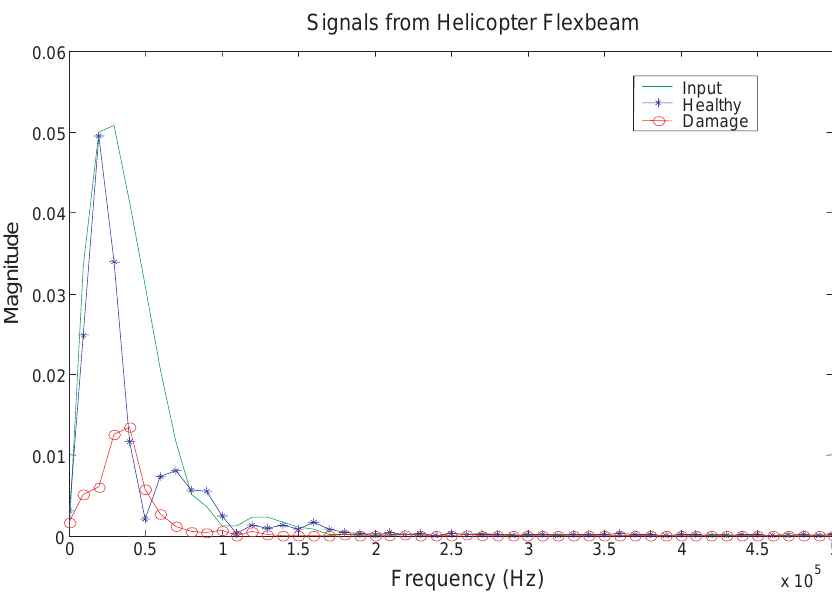
Fig. 18. FFT of the input, healthy, and damage responses of the flexbeam. (a) Contour plot of the 50 kHz sinusoidal input signal. (b) Mesh Plot of the 50 kHz sinusoidal input signal. ures 19(a, b) give the contour and mesh wavelet plots the healthy and the damaged leg responses. These are: for the input excitation, respectively. Figures 19(a, b) show that the amplitude is large for the frequencyrange forthe inputexcitationfrom0 to 60 kHz with maximum energy intensity near 35 kHz, occurring from 0.5ms to 0.75ms. The output response in Figs 20(a, b) from the healthy leg sensor S4 is given in the contour and mesh wavelet plots. The frequencyrange shown in Figs 20(a, b) of the healthy leg response at S4 is between 0 and 30 kHz with the maximum energy intensity occurring around 20 kHz from 0.25ms to 1.2ms. Figures 21(a, b) show the contour and mesh wavelet plots for the output response from the damaged leg sensor S2 near the delamination. The Figs 21(a, b) also show that the frequency range for the damaged leg output response at S2 is between 10 kHz and 50 kHz with maximum energy intensity at around from 0.4ms to 0.1ms. Clearly the time delay in the output response from the damaged leg sensor S2 near the delamination is longer than the output response from the healthy leg sensor S4. Also, the amplitude of the maximum energy for the healthy response ( ∼ 2.5) is larger than for the damaged response ( ∼ 0.25). This may occur because the material in the flexbeam attenuates the responses and the higher frequencies are suppressed as shown by comparingthe input excitation with the output response fromthe healthy leg sensor in Figs 19 and 20. However, Fig- the higher frequencies are reintroduced in the